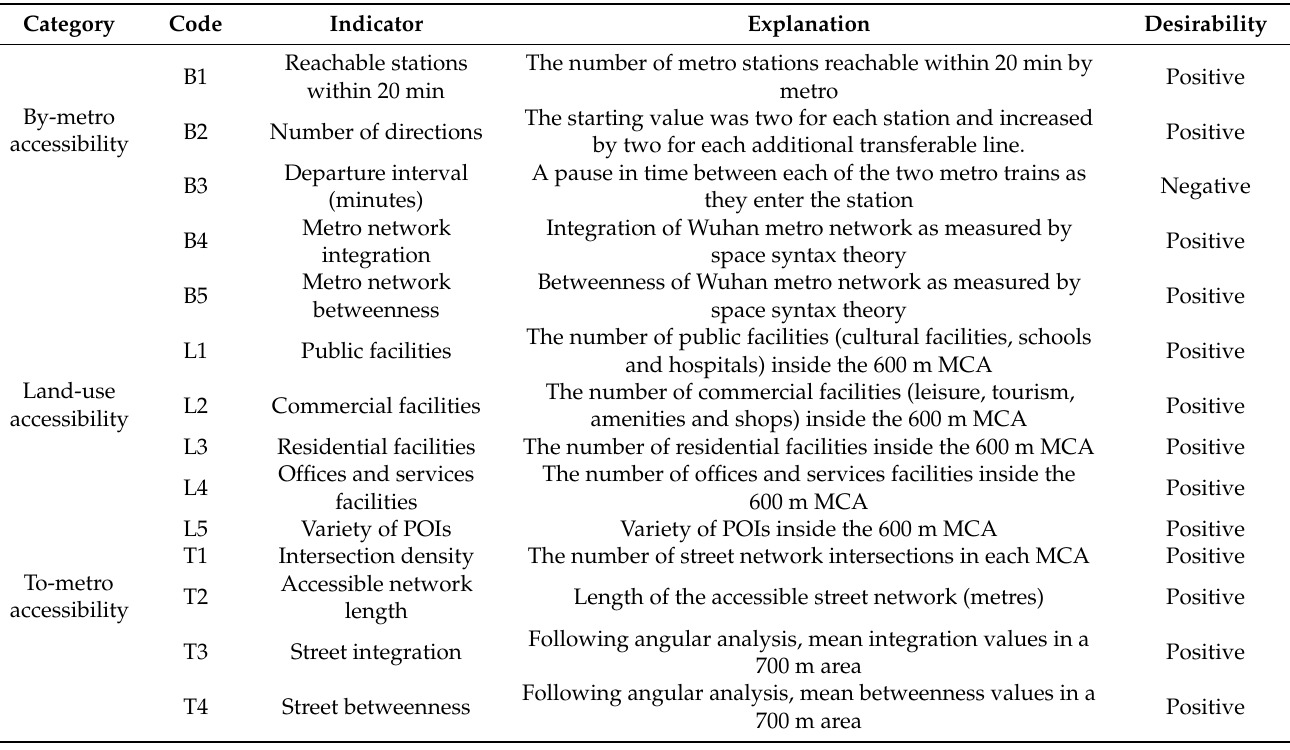
Table 1. Detailed explanation of metro-accessibility